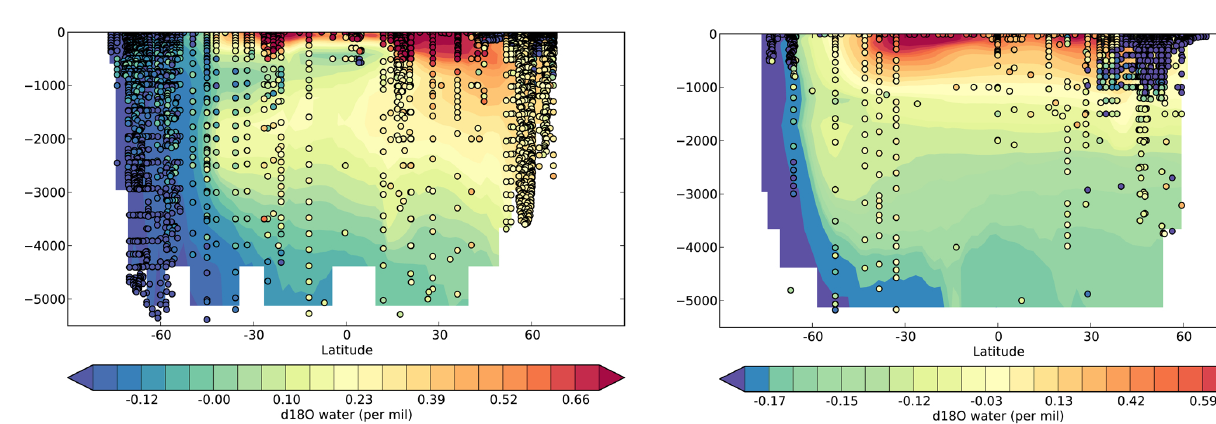
Fig. 14. Pacific zonal mean for the δ 18 O of seawater in i LOVECLIM compared to the GISS database (Schmidt et al., 1999) (coloured scale) presented as a latitudinal–depth (m)